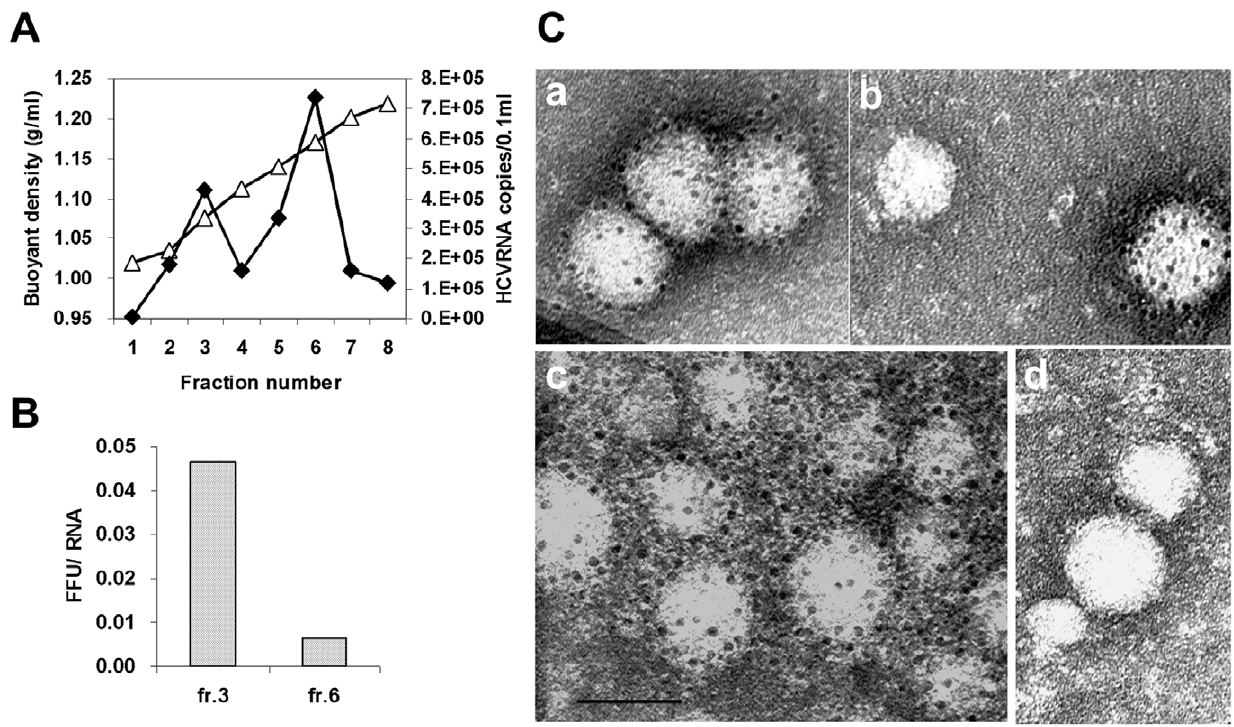
Figure 5. Immuno-gold EM demonstrated that both # 37 and # 55 recognized HCV intact particles. ( A ). Equilibrium SDG centrifugation. ¤ , HCV RNA copies measured by RT-qPCR; D , buoyant densities. ( B ). The ratio of infectivity titer (FFU) to HCV RNA copies of fractions 3 and 6. ( C ). Immuno-gold EM. Viral particles in fraction 3 were treated with # 37 ( a, b ), # 55 ( c ), or a control antibody ( d ) followed by anti-human IgG conjugated with colloidal gold particles, and examined under an electron microscope. HCV-like particles in the sample treated with # 37 and # 55 were observed with specific labeling of gold particles indicating that the antibodies are capable of binding to viral particles. Bar=50 nm.